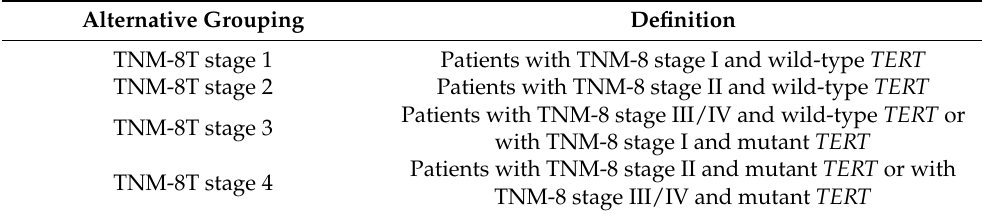
Table 3. Definition of the TNM-8T groups.